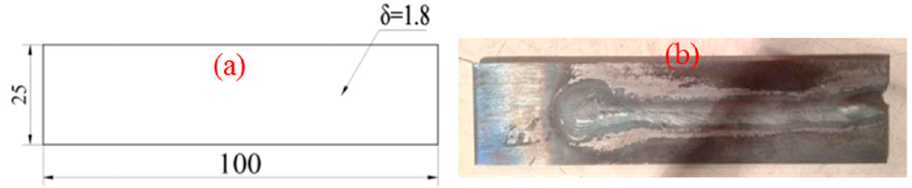
Figure 5. Diagram of test block ( a ) and surface of welded block ( b ) used for the diffusible hydrogen testing.